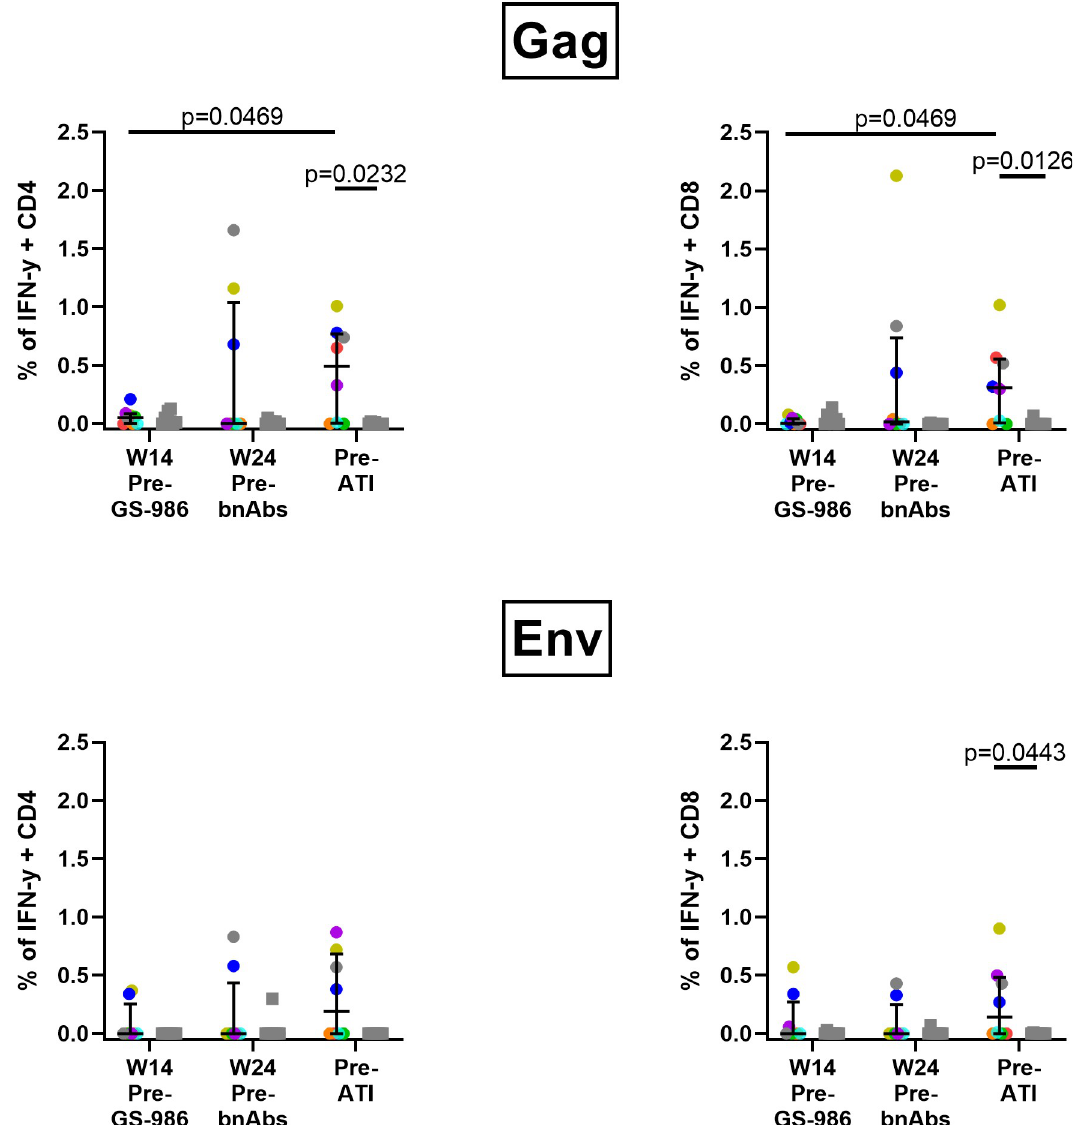
Fig 5. The combination of GS-986, N6-LS and PGT121 induced SHIV-specific T cell responses. The percentage of IFN γ + CD4 and CD8 T cells after stimulation with SIVmac239 Gag and HIV-1 Consensus C Env peptides are shown for wk 14 (pre-GS-986), wk 24 (2wks after the 5 th dose of GS-986, before bnAb administration) and immediately before ART interruption (pre-ATI). Data from animals in the active arm are displayed in color with each color corresponding to individual animals identified in Fig 4A. Data from animals in the control arm are displayed as gray